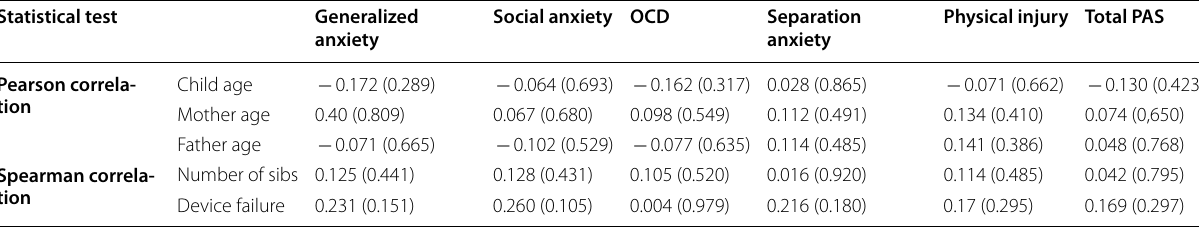
Table 1 Correlating independent variables to subscales crude scores and PAS total t -score using Pearson correlation for continuous variables and Spearman correlation for categorical variables